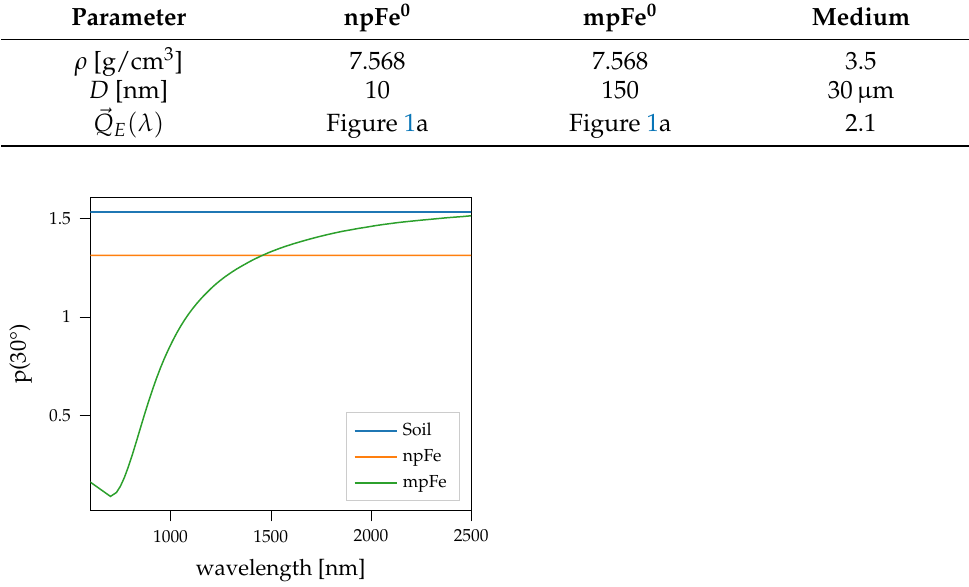
Figure 2. Phase function values for 30° phase angle. The Soil and the npFe 0 particles phase functions are independent of the wavelength in contrast to the mpFe 0